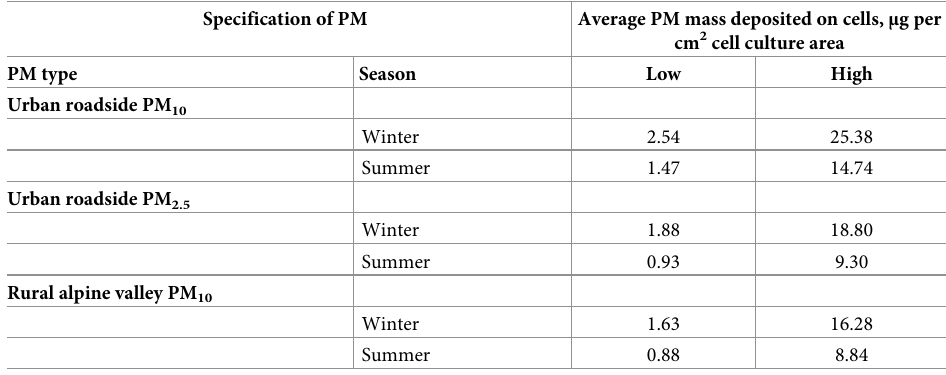
Table 1. Effective PM mass deposited on